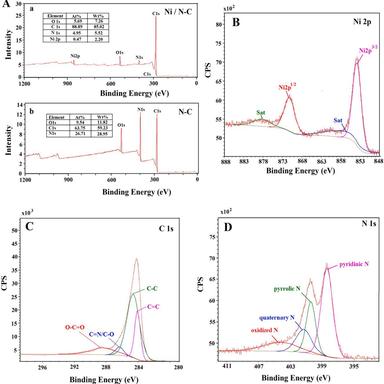
XPS spectra of the Ni NPs/N-C nanohybrid: (A) survey spectrum, (B) Ni 2p spectrum, (C) C 1s spectrum, (D) N 1s spectrum.